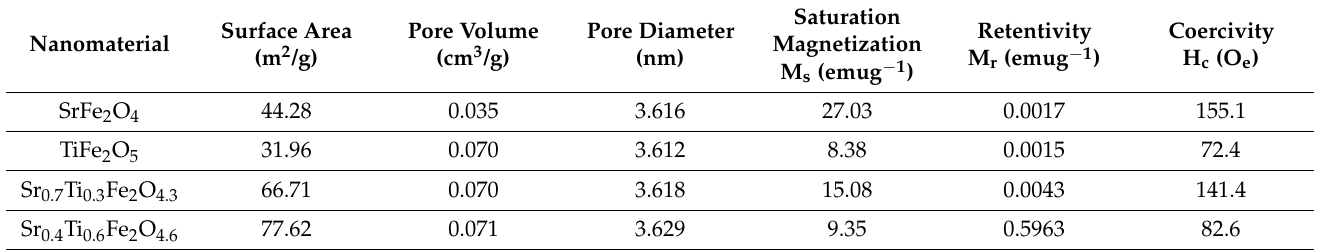
Figure 4. ( a ) Hysteresis curves of (I) SrFe 2 O 4 , (II) Sr 0.7 Ti 0.3 Fe 2 O 4.3 (III) Sr 0.4 Ti 0.6 Fe 2 O 4.6 and (IV) TiFe 2 O 5 , magnetic separation of Sr 0.4 Ti 0.6 Fe 2 O 4.6 (inset); ( b ) variation of saturation magnetization and coercivity; ( c ) variation of surface area and pore diameter. Table 2. BET and VSM parameters of SrFe 2 O 4 , TiFe 2 O 5 , Sr 0.7 Ti 0.3 Fe 2 O 4.3 and Sr 0.4 Ti 0.6 Fe 2 O 4.6.